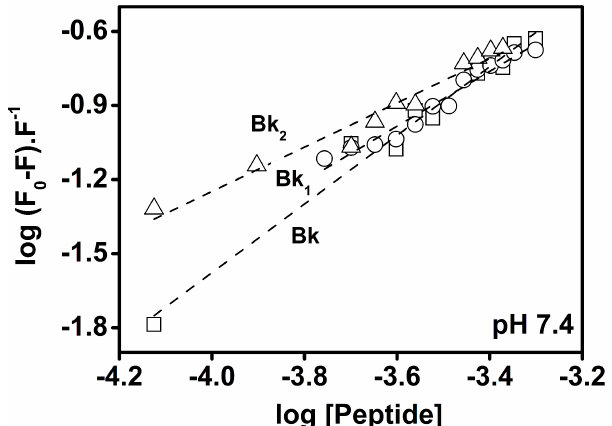
Figure 4. The plots of Log (F 0 − F/F) vs. Log [Peptide] for quenching of BTCI by Bk-related peptides, at pH